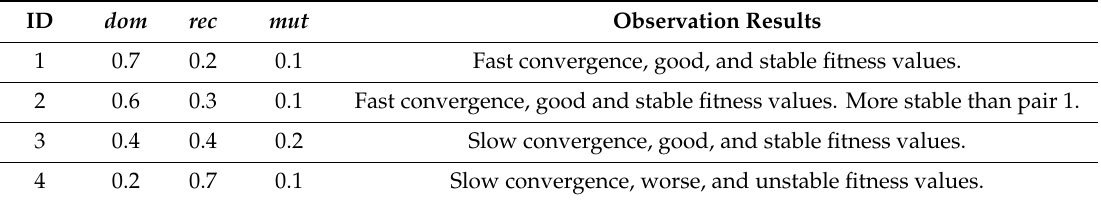
Table 1. Di ff erent pair values of the rates of the selection of recessive, dominant, and mutant genes during the crossover.